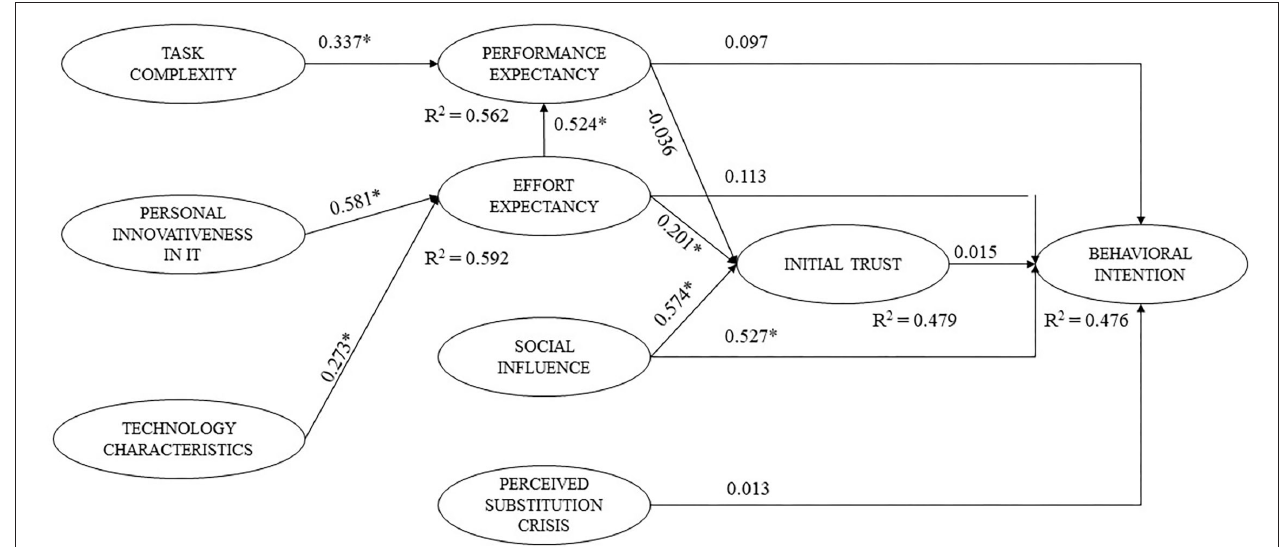
FIGURE 2 | Structural model and standardized path coefficients ( n = 211). * p <